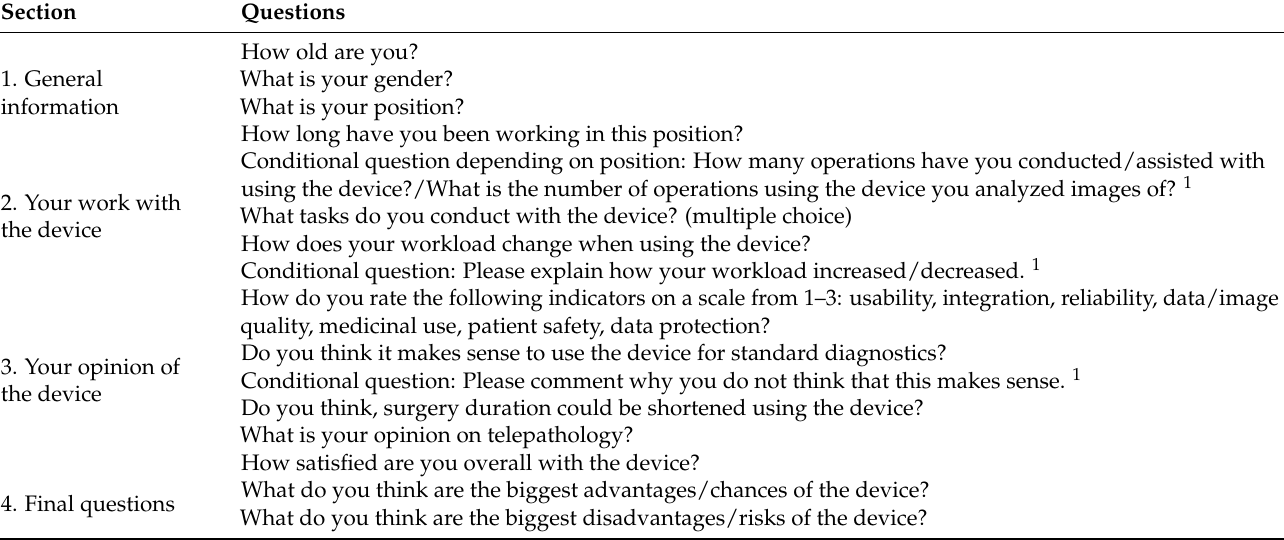
Table 1. List of all survey